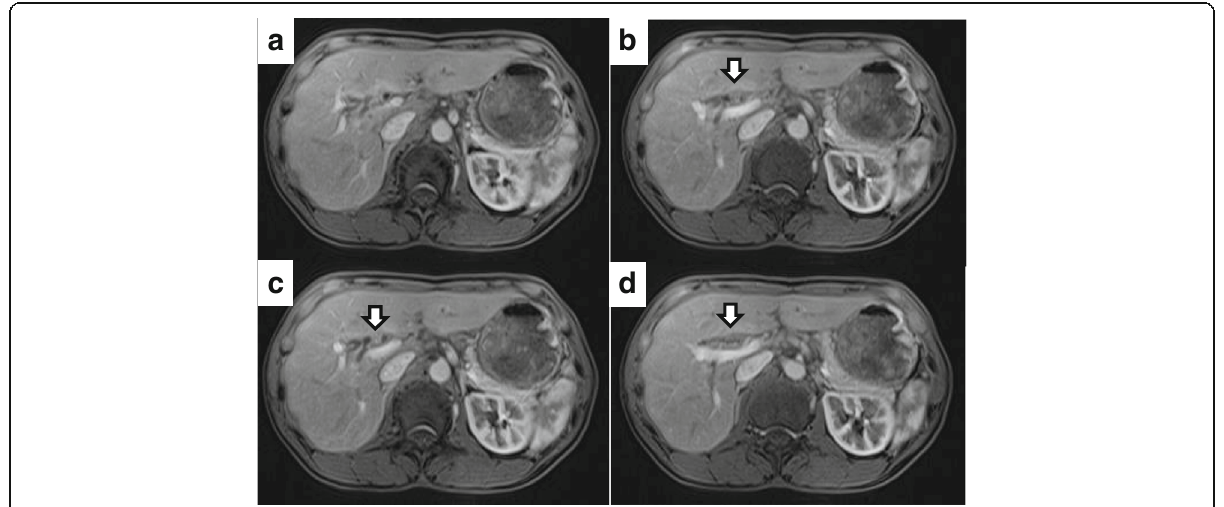
Fig. 2 Contrast-enhanced magnetic resonance imaging (MRI) findings. a – d Contrast-enhanced MRI showed dilation of the intrahepatic bile duct